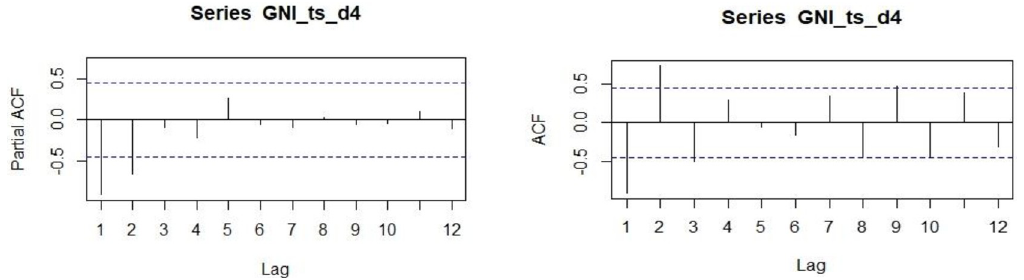
Fig 6. PACF and ACF plot of stationary